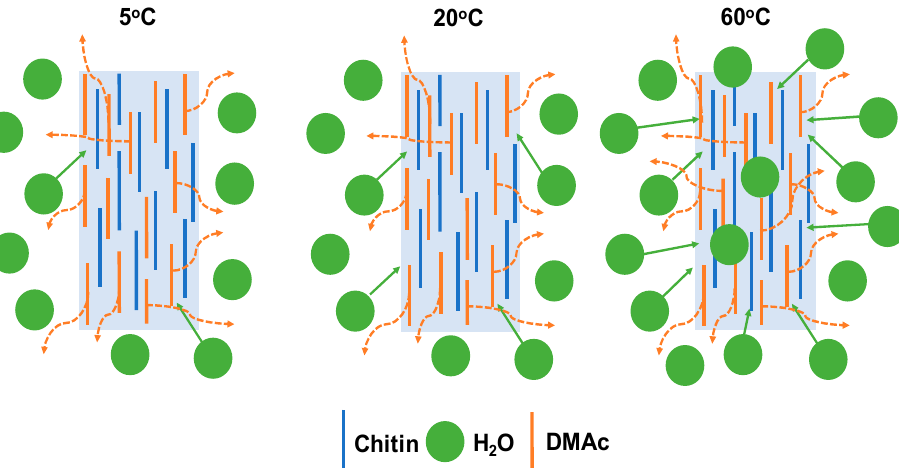
Figure 6. Proposed mechanism of the formation of chitin fiber at different temperatures of the water coagulation bath.